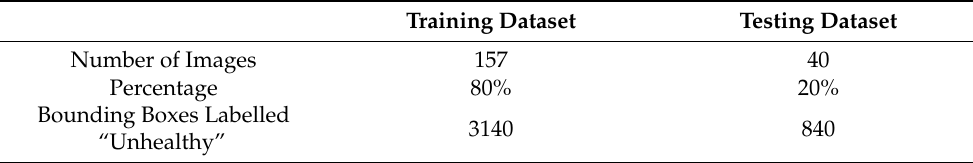
Figure 2. The process of data annotations using labelImg Software .